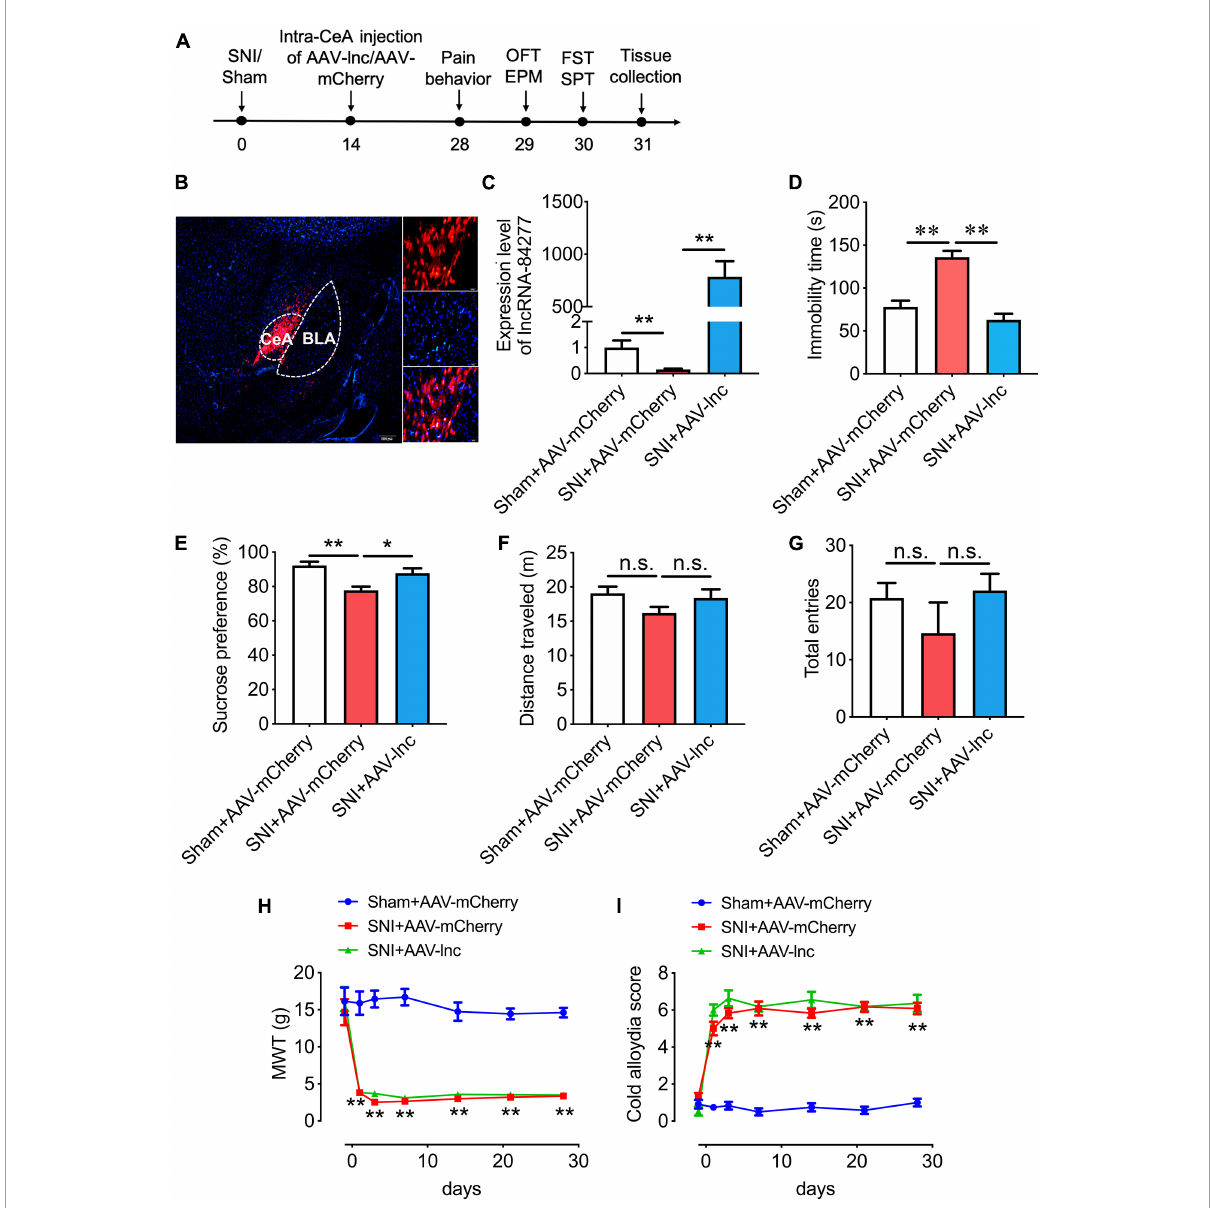
FIGURE2 LncRNA-84277 overexpression in CeA improves depression-like behaviors in SNI rats. (A) Experimental timeline. (B) mCherry fluorescence in CeA after injection of an AAV vector expressing lncRNA-84277 (AAV-lnc). (C) RT-qPCR analysis of lncRNA-84277 expression in CeA after injection of AAV-lnc ( n = 8). (D,E) Effect of lncRNA-84277 overexpression on depression-like behaviors in SNI rats assessed by the immobility time in the forced swim test (D) and sucrose consumption in the sucrose preference test (E) ( n = 8). (F,G) Effect of lncRNA-84277 overexpression on locomotor activity in SNI rats assessed by the total distance traveled in the open field test (F) and the total entries to open arms and closed arms in the elevated plus-maze test (G) ( n = 8–9). (H,I) Effect of lncRNA-84277 overexpression on sensory pain in SNI rats assessed by the mechanical withdrawal threshold (MWT) for mechanical allodynia (H) and the cold allodynia score for cold allodynia (I) ( n = 11–12). All data are expressed as the mean ± SEM. ∗ P < 0.05, ∗∗ P < 0.01. n.s., not significant. OFT, open field test; EPM, elevated plus-maze test; FST, forced swim test; SPT, sucrose preference